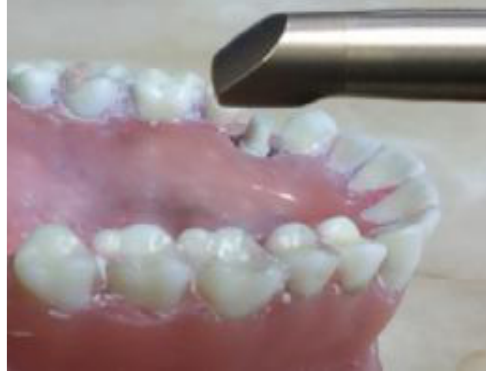
Figure 4: Scanning with Omnicam